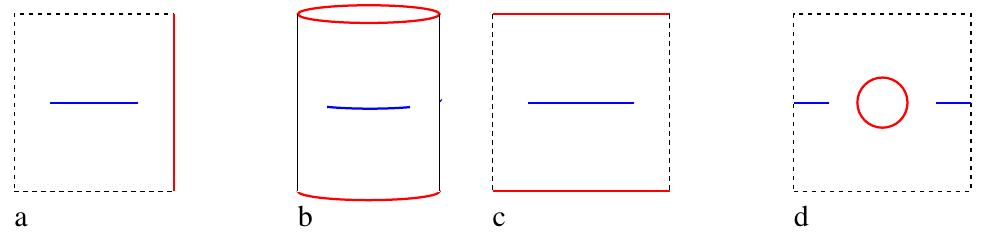
Figure 8 . Relation between Euclidean path integrals for the different BCFT setups in which we are calculating entanglement entropy. In (a), we have the half-space x > 0 . In (b), we have the path integral preparing the boundary state | b, τ 0 i . We decompactify from a circle to a line to obtain the global quench geometry (c), which is equivalent (under a global conformal transformation) to (a). In (d), we have the thermofield double state of